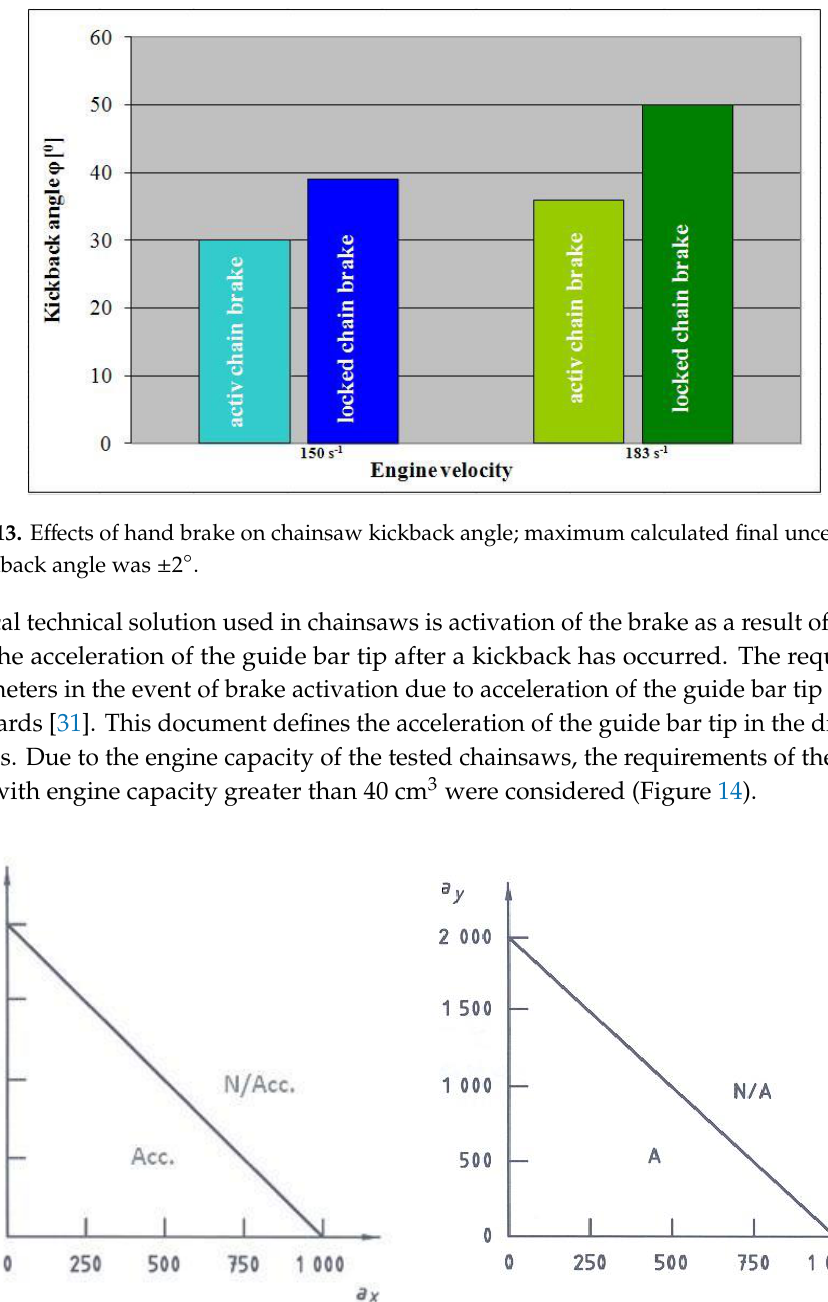
Figure 14. Threshold acceleration levels at the guide bar tip for activation of inertia-triggered chain brake on chainsaws for forestry service with engine capacity of > 40 cm 3 . a x , horizontal acceleration (m/s 2 ); a y , vertical acceleration (m/s 2 ); Acc., acceptable acceleration; N/A, non-acceptable acceleration.